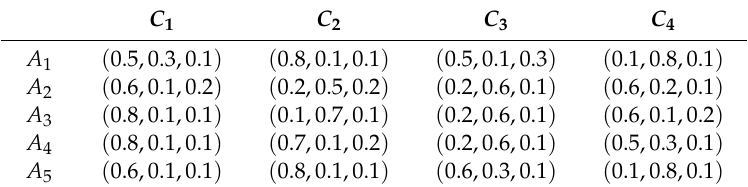
Table 2. Decision matrix A 2 from expert E 2 .